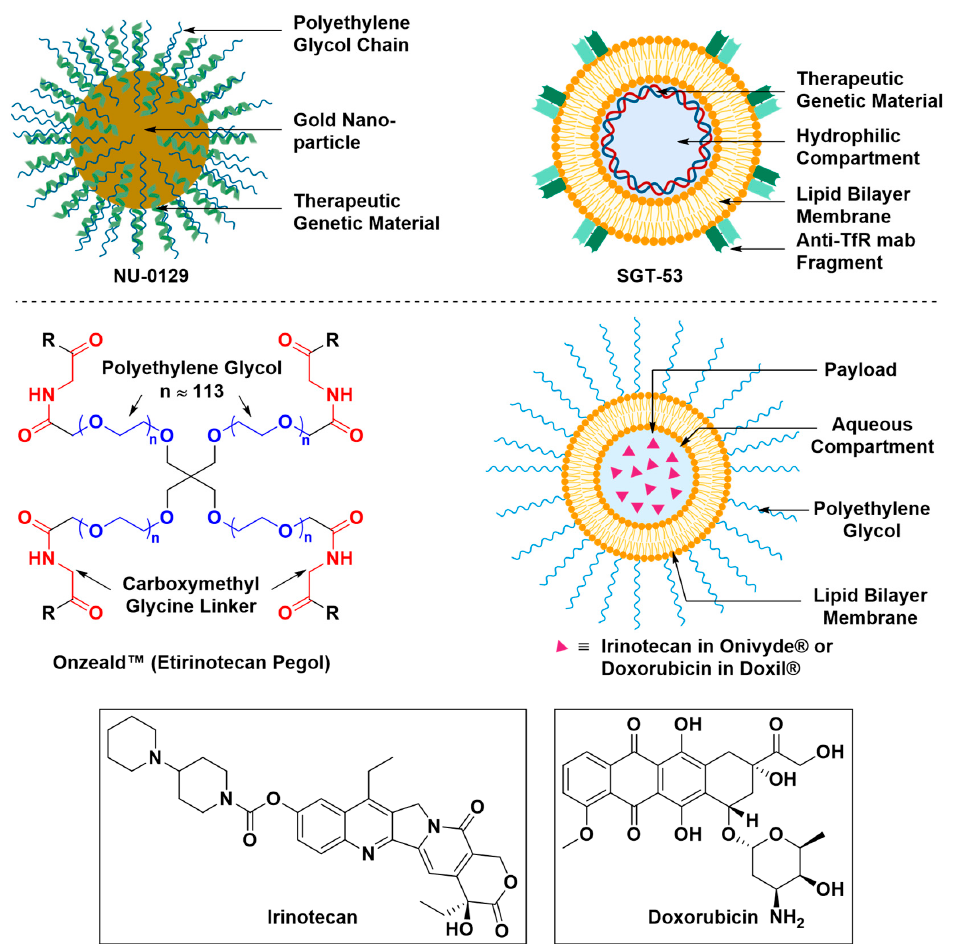
Figure 21. Nanoscopic formulations for the delivery of therapeutics to the brain. NU-0129 is a gold nanoparticle formulation whose surface is conjugated with of polyethylene glycol chains and small interfering RNAs (siRNAs) that target the Bcl-2-like protein. NU-0129 is currently under clinical trial for its antineoplastic activity and potential in the treatment of recurrent glioblastoma multiforme. SGT-53 is a cationic liposome in complex with its cargo, a genetic therapeutic material. The liposomal surface is conjugated with an anti-transferrin receptor single-chain antibody fragment that serves as the targeting vector. SGT-53 is currently under clinical trial for its potential to induce apoptosis in patients with recurrent glioblastoma. Onzeald ® (or etirinotecan pegol) is a pegylated irinotecan formulation with a long-acting effect. Onzeald TM is currently under clinical trial to evaluate its efficacy at the control of brain metastases. Onivyde ® and Doxil ® are liposomal formulations that encapsulate irinotecan and doxorubicin, respectively, in an aqueous space. The liposomal surface of Onivyde ® and Doxil ® is conjugated with chains of polyethylene glycol to improve their colloidal stability and non-immunogenicity. Because of their long-acting effect, Onivyde ® and Doxil ® are under clinical trials to evaluate their efficacy at treating patients with glioblastoma. Doxil ® is also under pre-clinical investigation to assess its efficiency at the treatment glioblastoma after transient disruption of the BBB induced by microbubble-assisted focused ultrasound (MB-FUS).